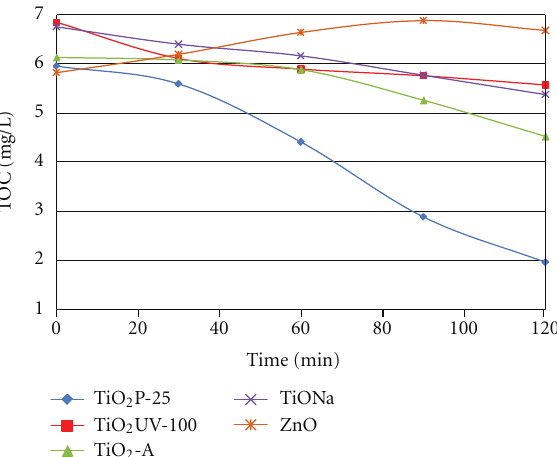
Figure 2: Photocatalysis experimental setup ((1) photochemical reactor, (2) pierced cap, (3) quart glass tube, (4) plastic tubes, (5) compressor, (6) magnetic range, (7) magnetic steered, (8) UV lamp).